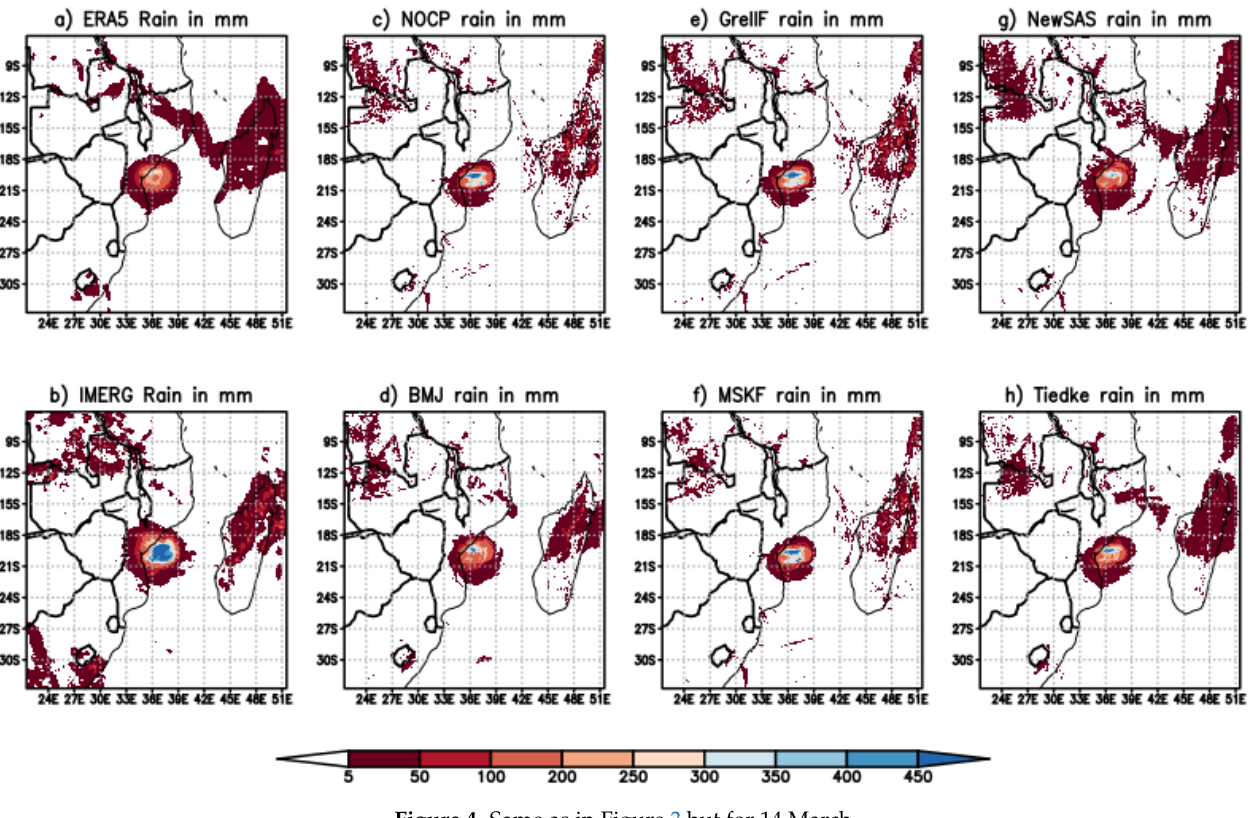
Figure 4. Same as in Figure 3 but for 14 March.